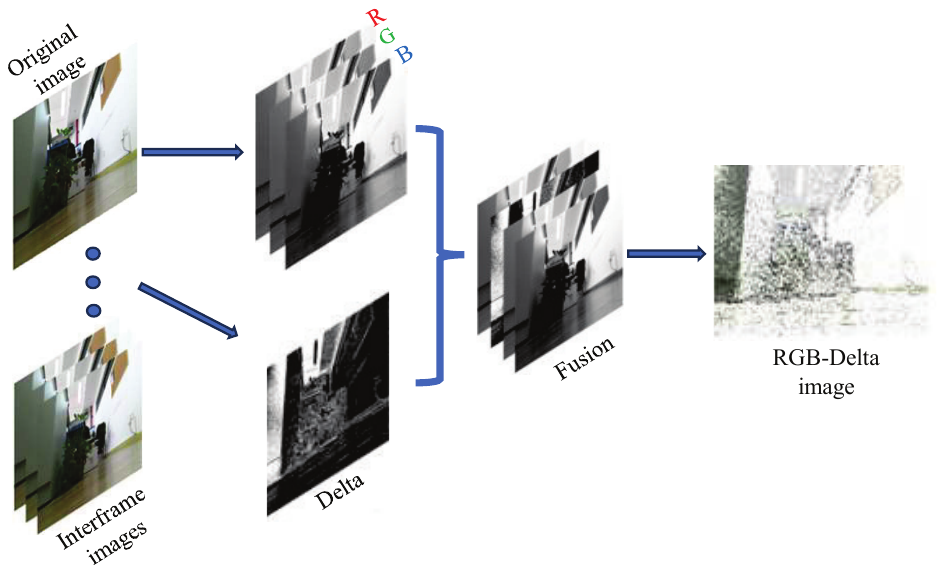
Figure 5. RGB-Delta image fusion process.